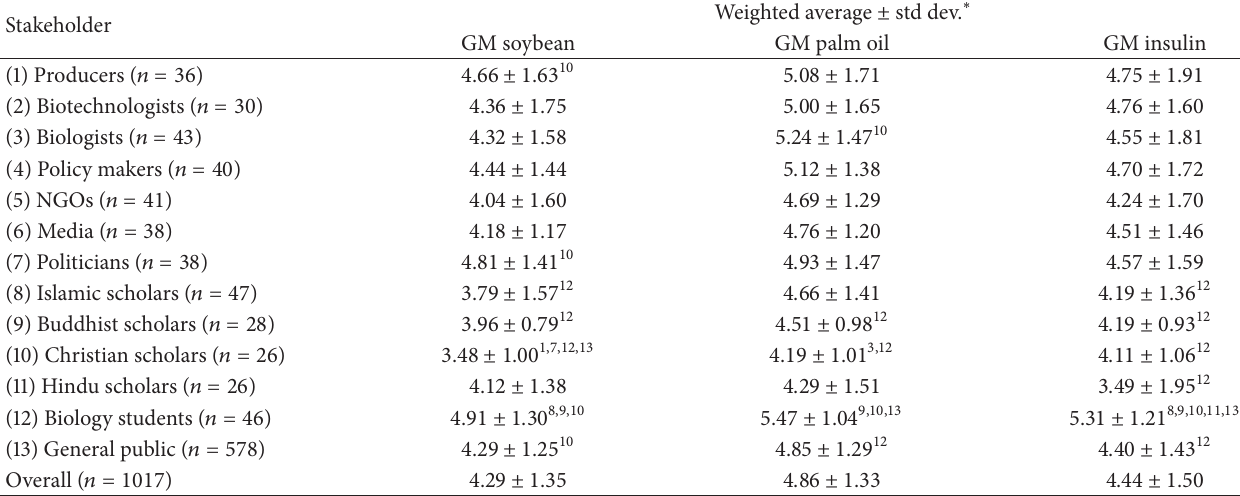
Table 9: Weighted average and post hoc test results for encouragement of GM foods and GM insulin.